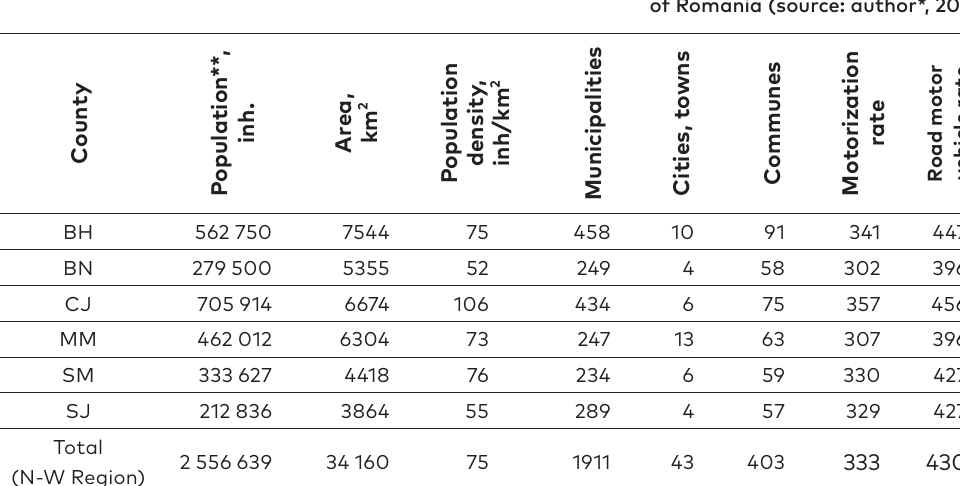
Table 1. Characteristics of the counties in the N-W